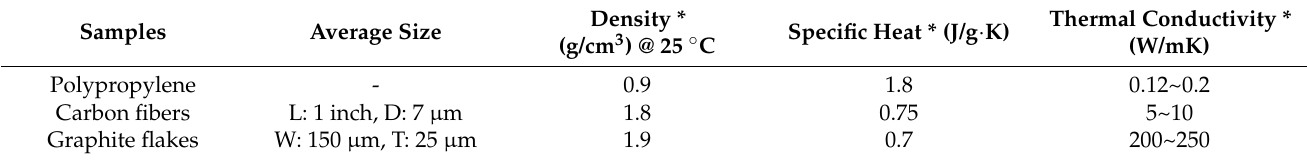
Table 1. Typical thermophysical properties of the materials used.